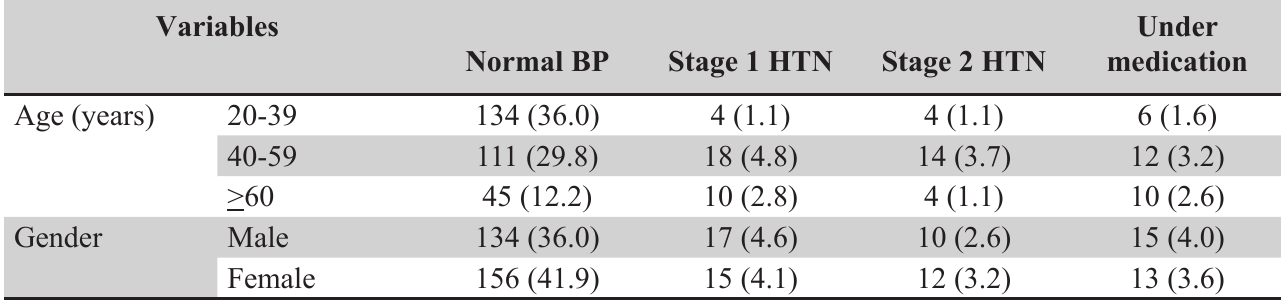
Table 1. Demographic characteristics of the study population (N=372).